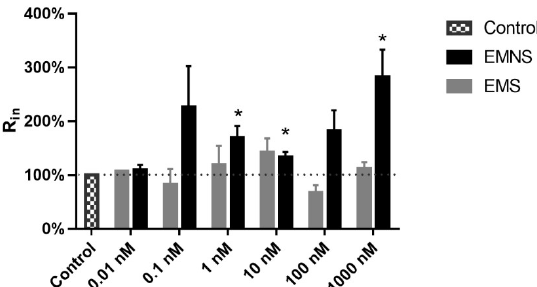
Figure 4. Effect of melatonin on the input resistance (R in ) of N inf excitability melatonin sensitive (EMS) and excitability melatonin not sensitive (EMNS) cells. These data, expressed in normalized values, are presented as means ± SEM and R in absolute control values are found in Table 1. The number of experiments of N inf EMS neurons at concentrations of 0.01, 0.1, 1.0, 10.0, 100.0, and 1000.0 nM were 1, 4, 6, 10, 3, and, 10, respectively. The number of experiments of N inf EMNS neurons at concentrations of 0.01, 0.1, 1.0, 10.0, 100.0, and 1000.0 nM were 13, 7, 12, 15, 10, and 18, respectively. The symbol * indicates statistically significant difference as compared to control ( p < 0.05, paired Student’s t -test).